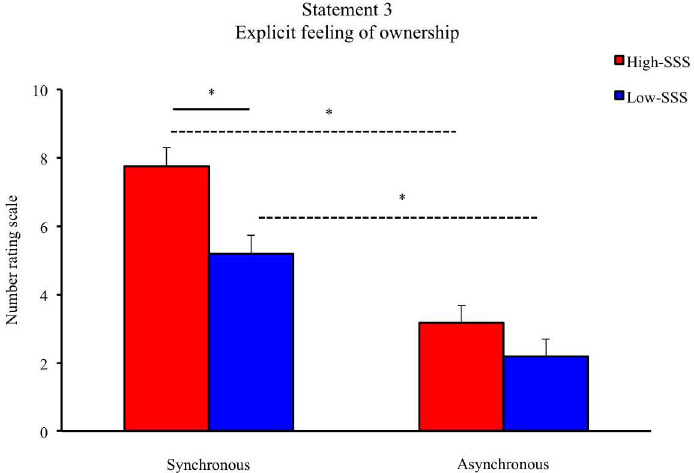
Fig 1. Mean scores for S3 related to an explicit feeling of ownership after synchronous and asynchronous stroking. The solid line shows a significantdifference in scores betweenthe two groups in the synchronous condition. The dashedlines indicate significantdifferences betweensynchronous and asynchronous conditionswithin each group. In both groups, the experience of illusionwas rated higherafter synchronous than after asynchronous stimulation.Error bars represent standard errors.